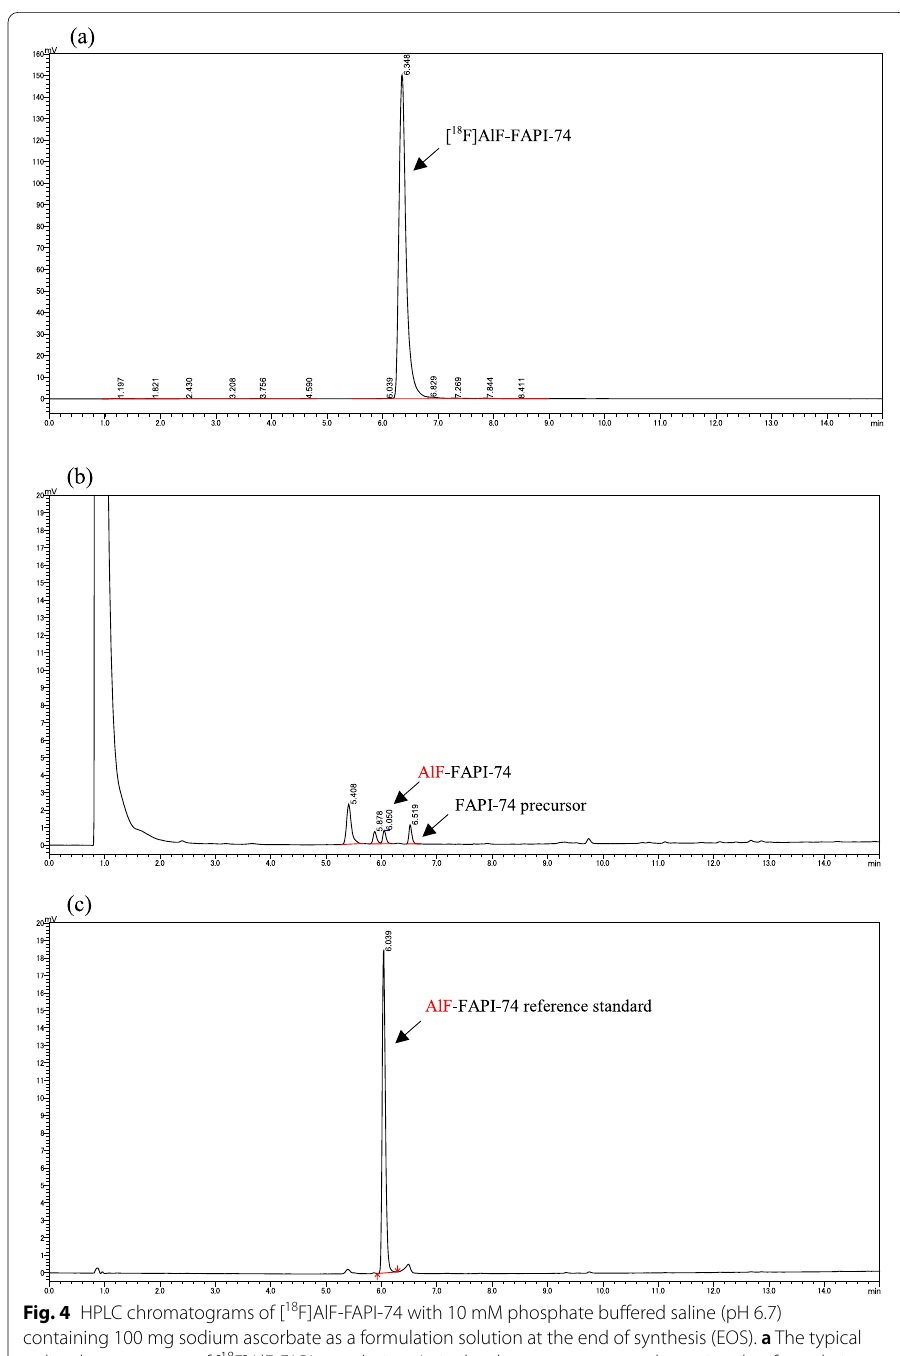
Fig. 4 HPLC chromatograms of [ 18 F]AlF-FAPI-74 with 10 mM phosphate buffered saline (pH 6.7) containing 100 mg sodium ascorbate as a formulation solution at the end of synthesis (EOS). a The typical radio-chromatogram of [ 18 F]AlF-FAPI-74 solution. A similar chromatogram was shown in other formulation solutions and its radiochemical purity was 97%. b The typical ultraviolet (UV)-chromatogram (λ 264 nm) ≥ = of [ 18 F]AlF-FAPI-74 solution. In the chromatogram, retention time (RT) 6.050 min was judged to be AlF-FAPI-74 based on the RT obtained from the AlF-FAPI-74 reference standard ( c ) and there is a time difference of approximately 0.3 min with the radioactivity detector. RT 6.519 min was judged to be FAPI-74 precursor based on prior analysis, and the remaining two peaks (RT 5.408 min and 5.878 min) were unknown impurity peaks. c The typical UV-chromatogram (λ 264 nm) of AlF-FAPI-74 reference standard of 10 µg/mL (RT = 6.039